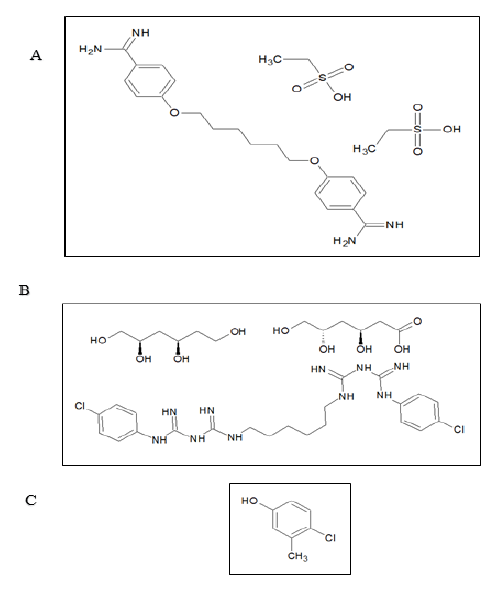
Fig. 1. The chemical structure of a) HEX b) CHX c) CSOL. (The structures were drawn by a Chem-Sketch